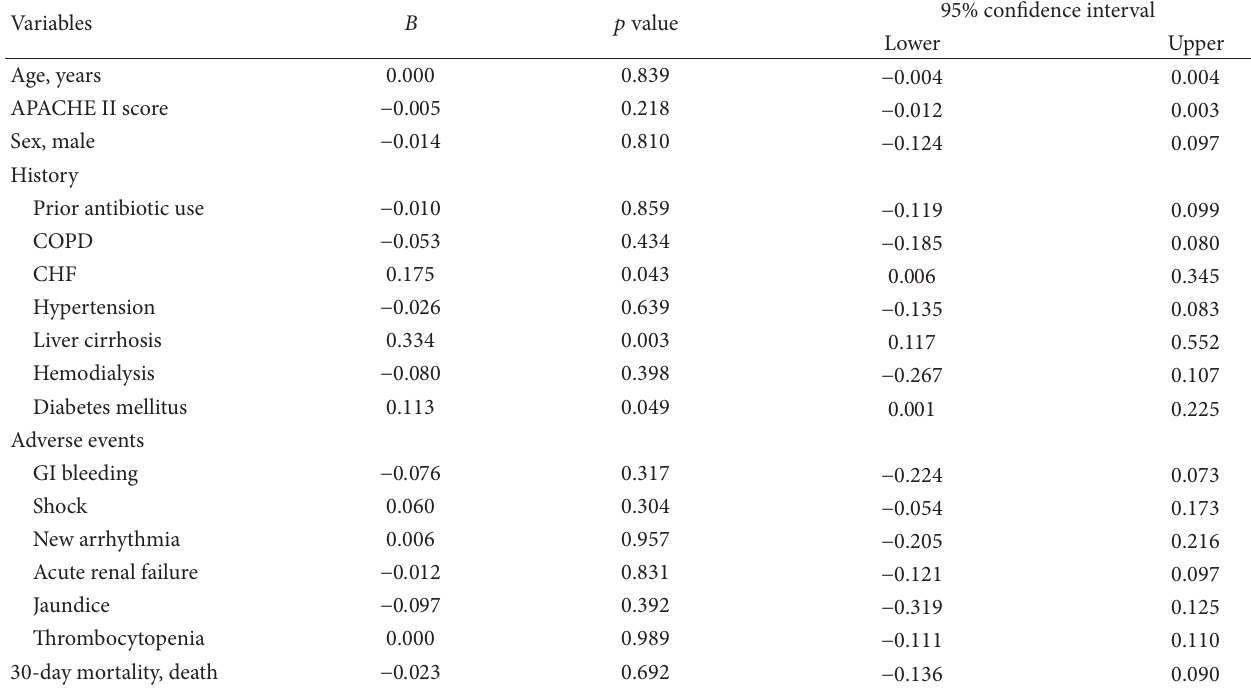
Table 4: General linear model to predict Staphylococcus aureus